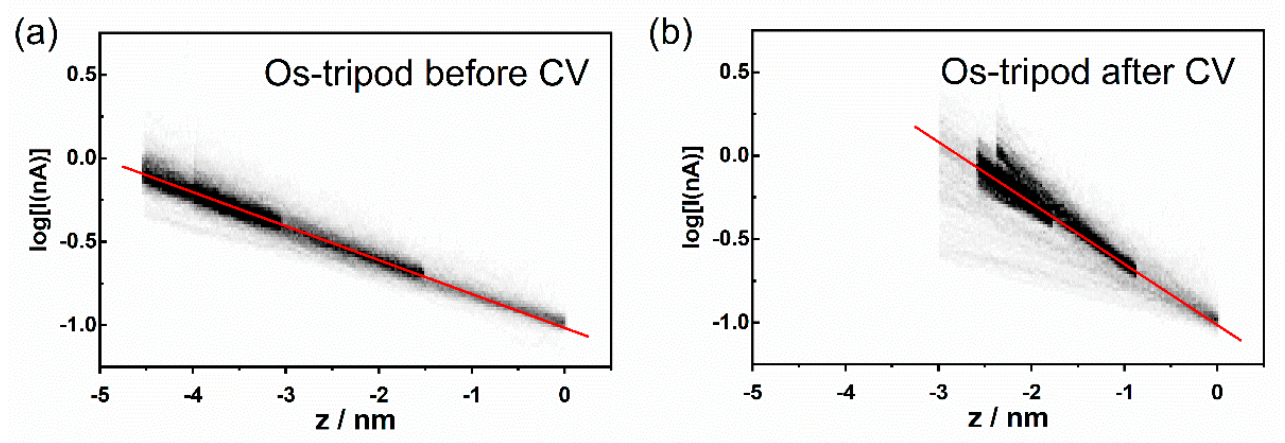
Figure 8. 2D semilogarithmic histogram of tunneling current–distance (I–z) curves for the Os-tripod SAM on Au(111): ( a ) before; ( b ) after cyclic voltammetry experiment. Three sets of I–z curves were measured starting at setpoint currents of 0.1 nA, 0.2 nA and 0.4 nA. Approach rate was 1 nm s − 1 , bin size log(I) = 0.02, z = 0.02 nm. Red line represents the best least square fit of the most probable log(I) values as a function of z.